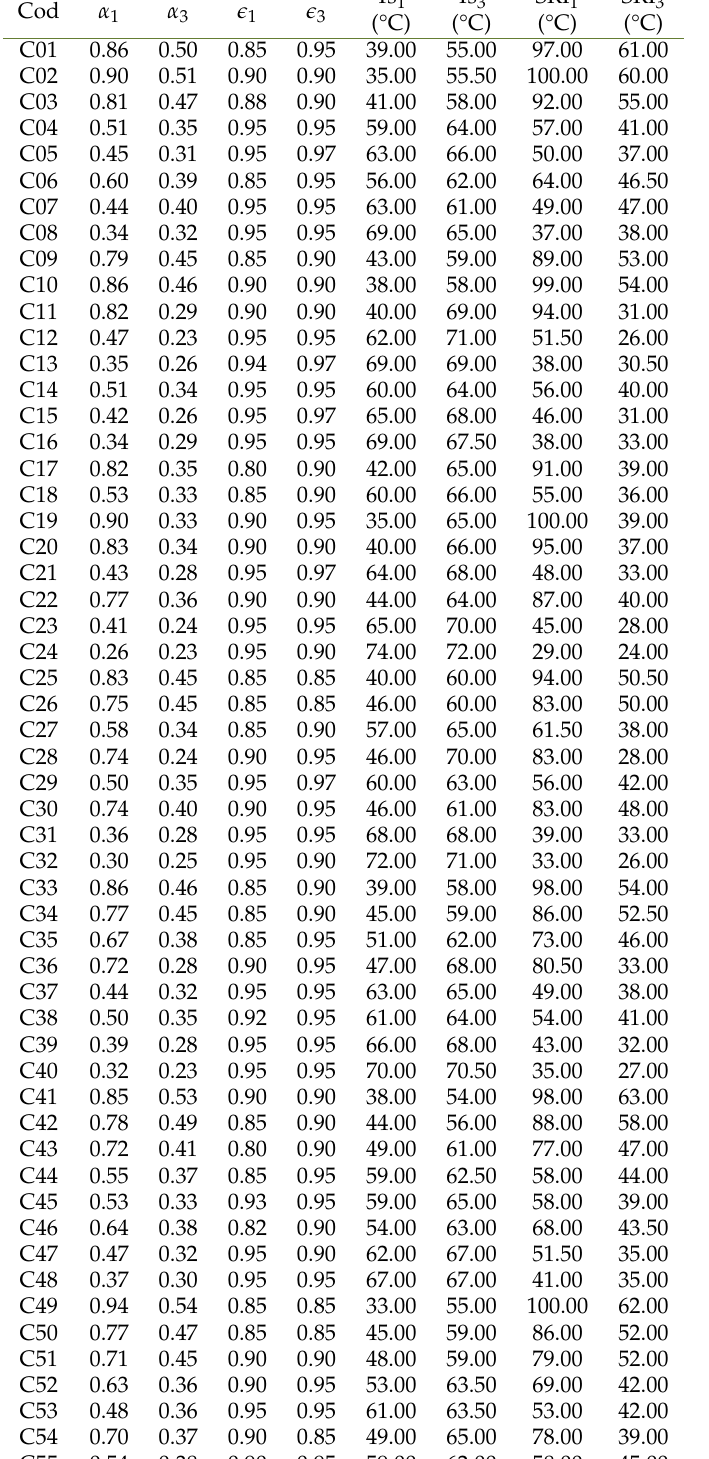
Table 1. Morphological characteristics and optothermal properties of textured coatings. Initial albedo ( α 1 ) and aged ( α 3 ); initial emissivity ( (cid:101) 1 ) and aged ( (cid:101) 3 ); initial surface temperature (Ts 1 , °C) and aged (Ts 3 , °C); Solar Initial Reflective Index (SRI 1 , %) and aged (SRI 3 ,